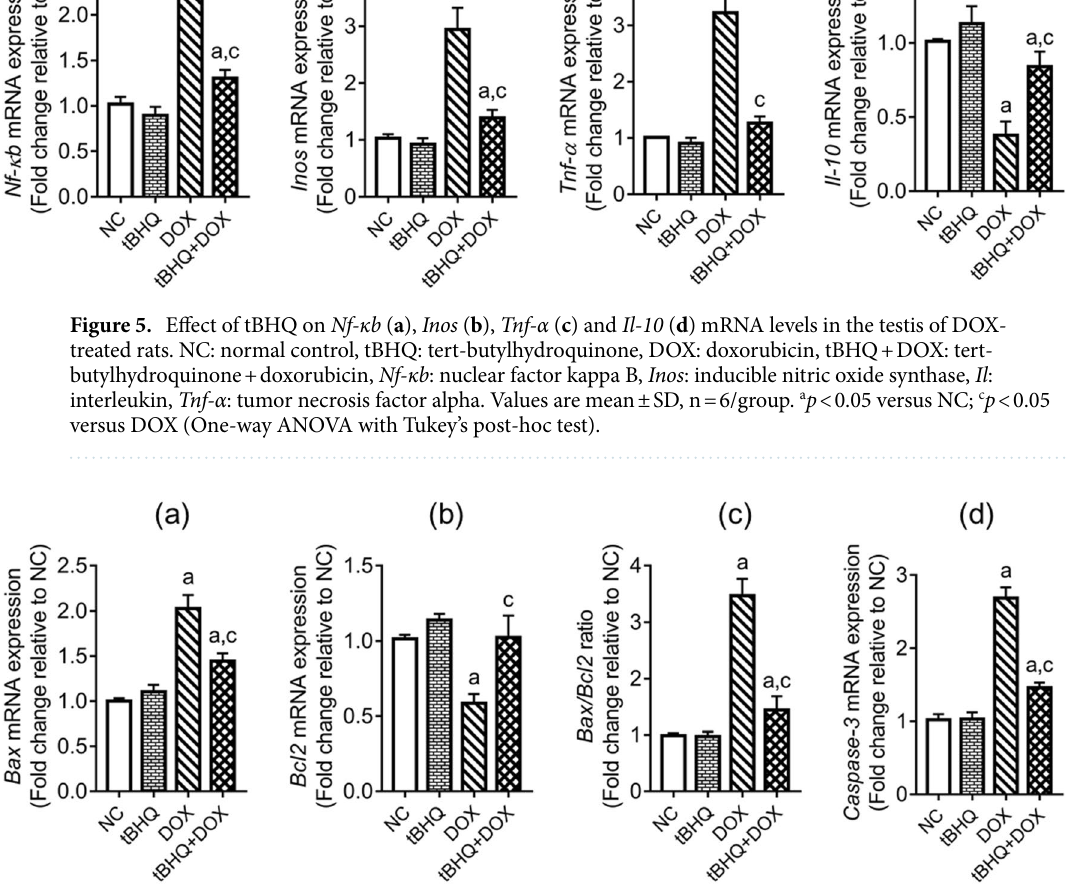
Figure 6. Effect of tBHQ on Bax ( a ), Bcl2 ( b ), Bax/Bcl2 ratio ( c ) and Caspase-3 ( d ) mRNA levels in the testis of DOX-treated rats. NC: normal control, tBHQ: tert-butylhydroquinone, DOX: doxorubicin, tBHQ + DOX: tert-butylhydroquinone + doxorubicin, Bcl-2 : Beta cell lymphoma-2, Bax : Bcl-2-associated X protein. Values are mean ± SD, n = 6. a p < 0.05 versus NC; c p < 0.05 versus DOX (One-way ANOVA with Tukey’s post-hoc